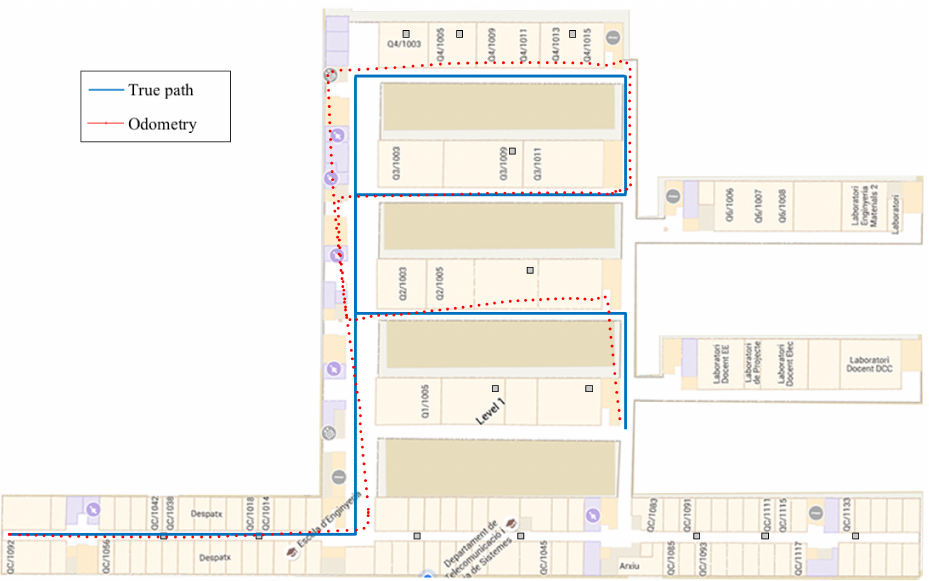
Figure 7. Path 3 and odometry obtained with the pocket navigation